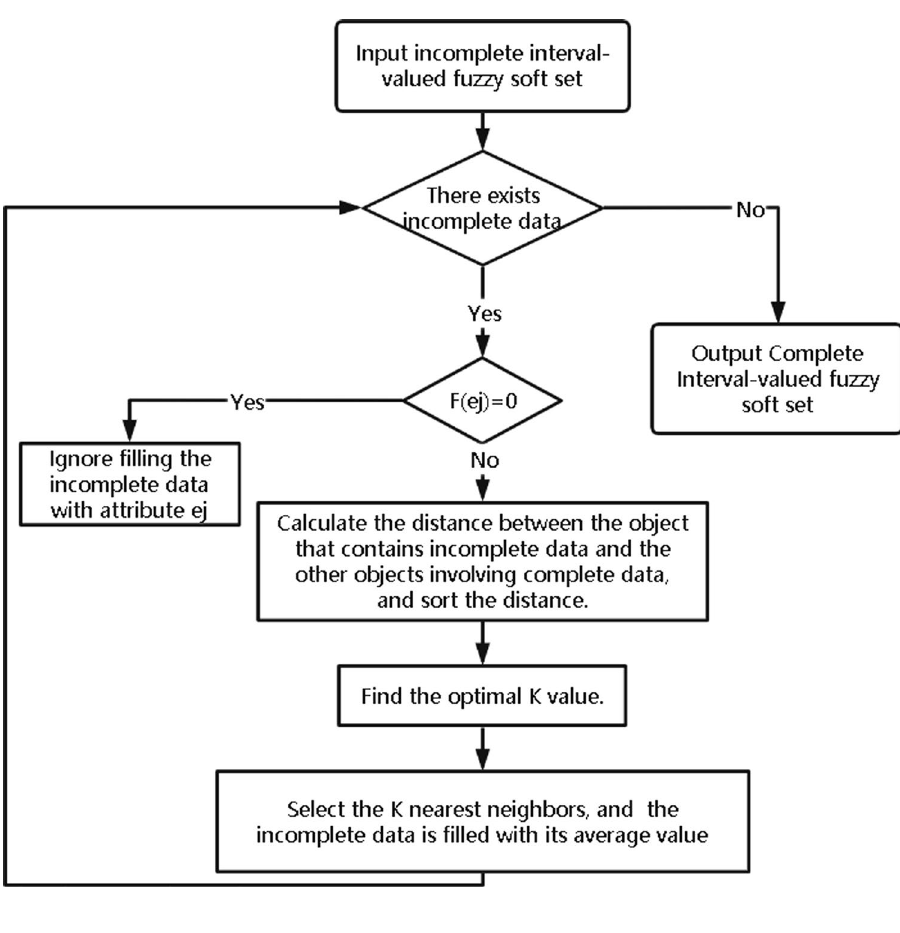
Fig. 1 Flow chart of KNN data filling method